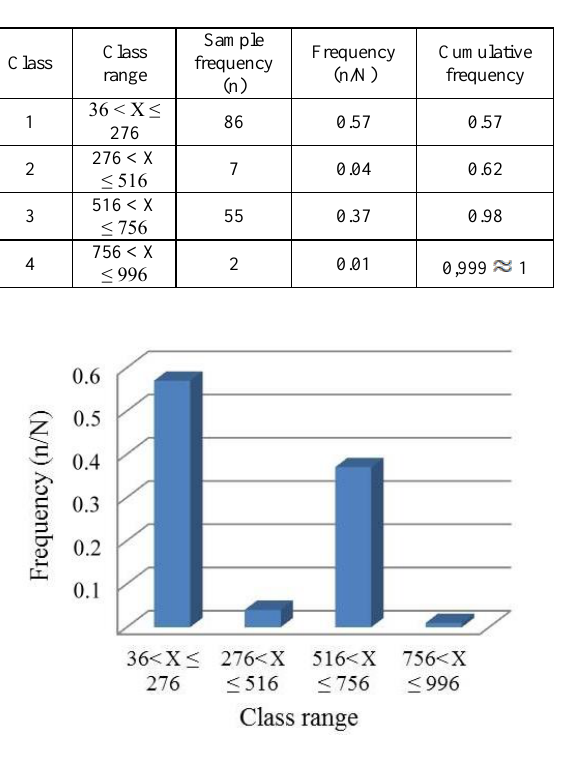
Figure 2. Distribution of TSS